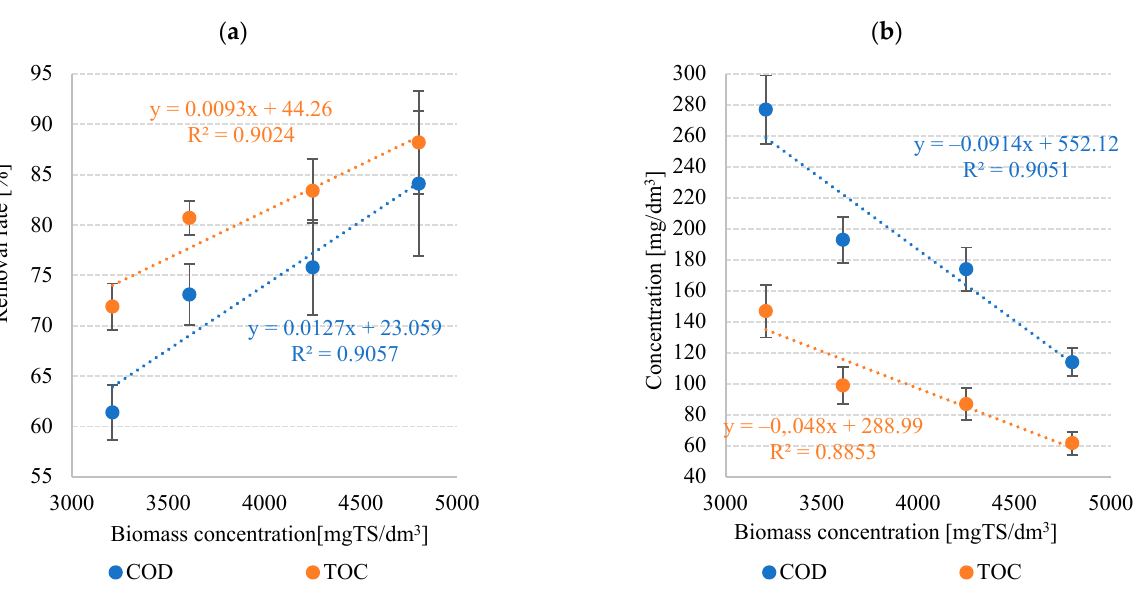
The different rates of organics biodegradation produced significant variance in the loads removed during LF-DSS treatment. COD removal ranged from 44.1 ± 3.5 gCOD/d in P1 to 60.5 ± 4.8 gCOD/d in P4. The rates for TOC ranged from 37.7 ± 4.4 gCOD/d in P1 to 46.2 ± 5.5 gCOD/d in P4 (Table 5). The biomass levels in the H-PBR (Figure 13) and the proportion of heterotrophic microbes in the M-BGS were found to correlate with organic removal rates and final organic levels (Figure 14).